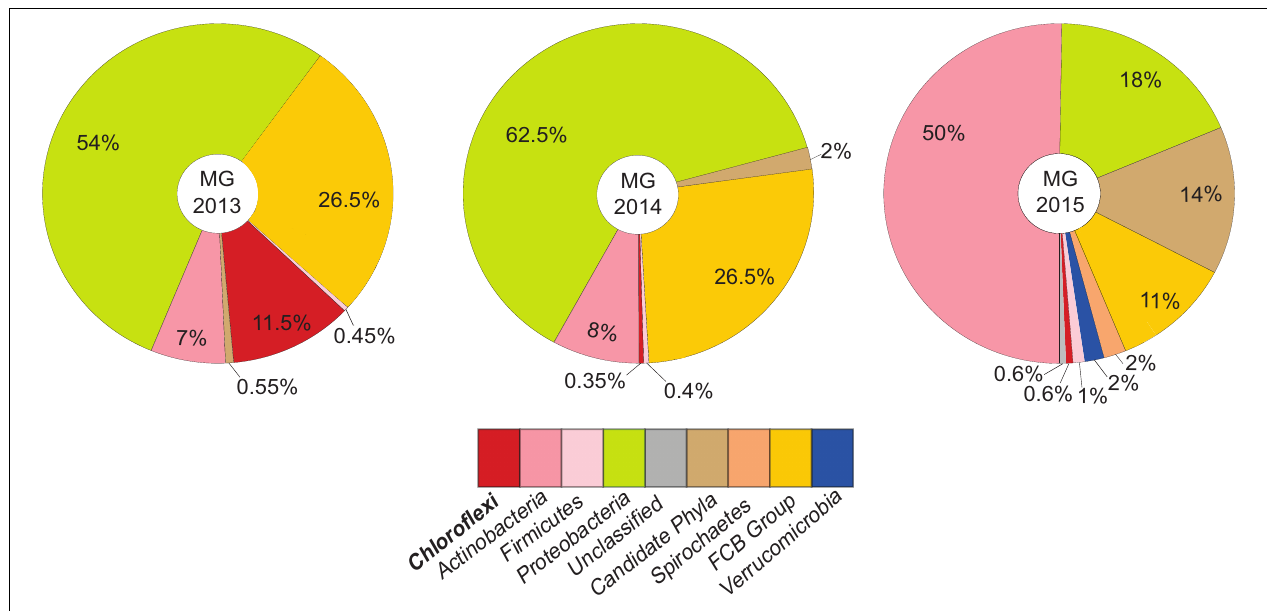
FIGURE 3 | Taxonomic composition and relative abundances of organisms represented by metagenome assembled genomes (MAGs) from WWTP samples over a period of three years. Relative proportions between MAGs were determined based on average contig coverages of each MAG in relation to the overall coverage of binned contigs for each metagenome, thereby correcting for potential differences in genome size and completeness. The fraction of sequence information that could be successfully binned represented 67–73% of the sequence data that could be assembled into contigs > 1 kbp (see also Supplementary Figure 7 ). The resulting relative abundances between binned taxa largely reflect the corresponding taxon proportions of the community observed via marker gene analyses of the complete metagenomes (see also Figure 2